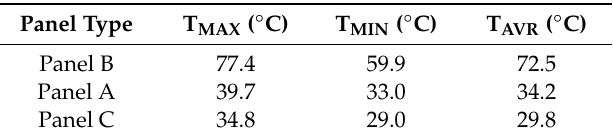
Table 1. Temperatures read in the measuring fields of the thermogram made for the stationary stand. The thermograms were obtained in weather conditions close to windless conditions, with a low average wind speed of up to 1.6 m / s. The maximum recorded values of solar radiation intensity were within the range of 716.7 W / m 2 –738.4 W / m 2 .